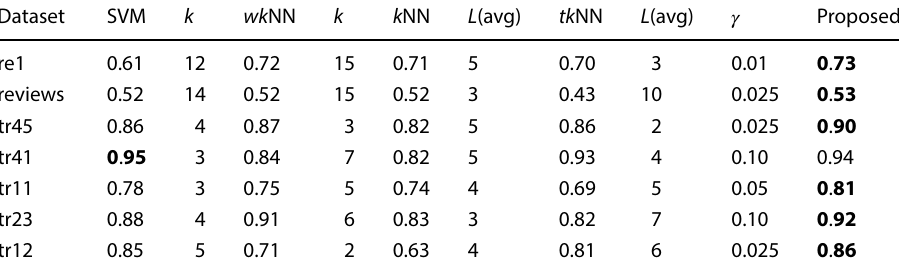
Bold value indicates the best performance (i.e., the highest value) in